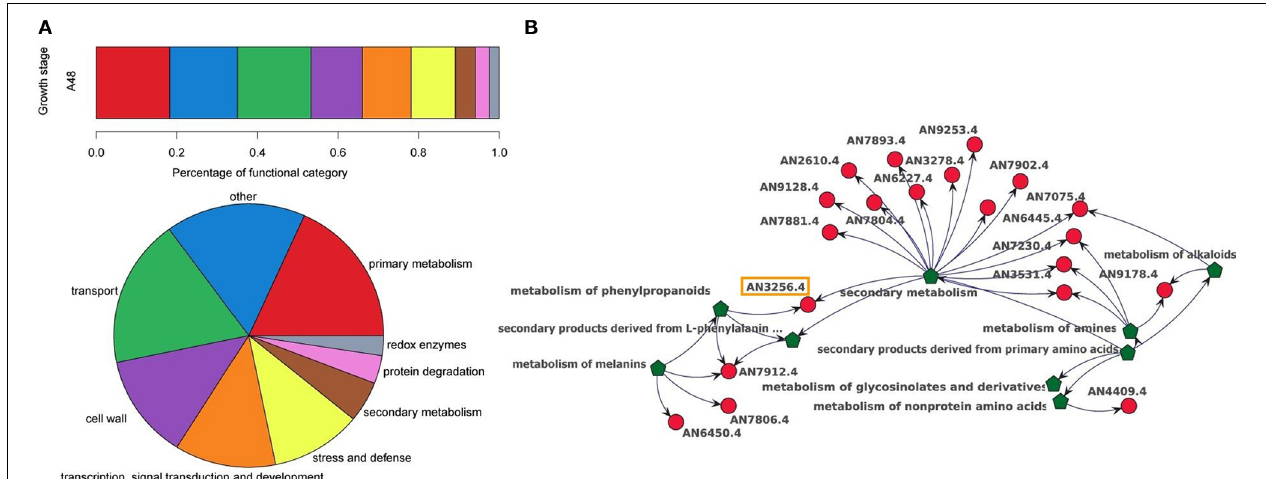
FIGURE 3 | Different visualization types of the distribution of functional annotations. (A) Bar and pie chart diagram representing the percentage of prominent biological processes within the strongly differentially expressed genes (|fold-change| ≥ 8, adjusted P-value ≤ 0.05). Example charts are shown for the asexual developmental growth stage after 48h (A48). (B) A detail of the sub-network representing the mapping between functional categories and strongly differentially expressed genes during the sexual development after 48h. Green polygonic concepts represent gene ontology concepts,